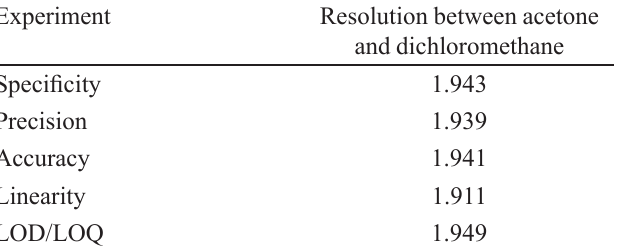
TABLE V - System suitability under robustness condition Conditions